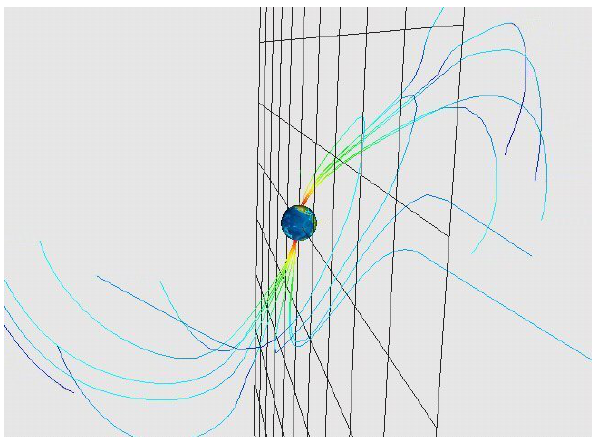
Fig. 5. Screen dump from the Orbit Visualization Tool showing the Earth, the outermost set of magnetic field lines as calculated from the Tsyganenko96 model and the field line passing though Astrid-2 (bottom side of the Earth, not shown). Note the twisting of the field lines relative to the x − z plane